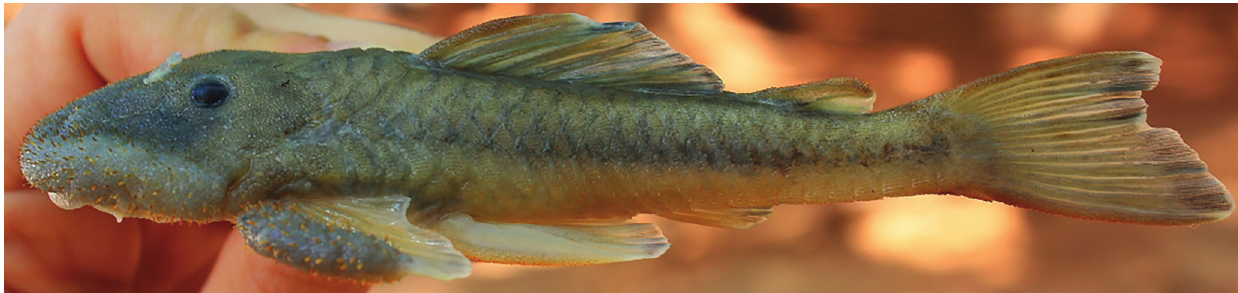
Fig. 2. Pareiorhaphis lineata , MCP 50879, 96.9 mm SL, paratype photographed right after preservation. Brazil, Minas Gerais State, Cristália, rio